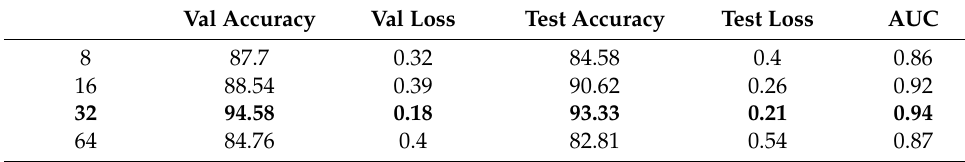
Table 1. Comparison of results of different batch